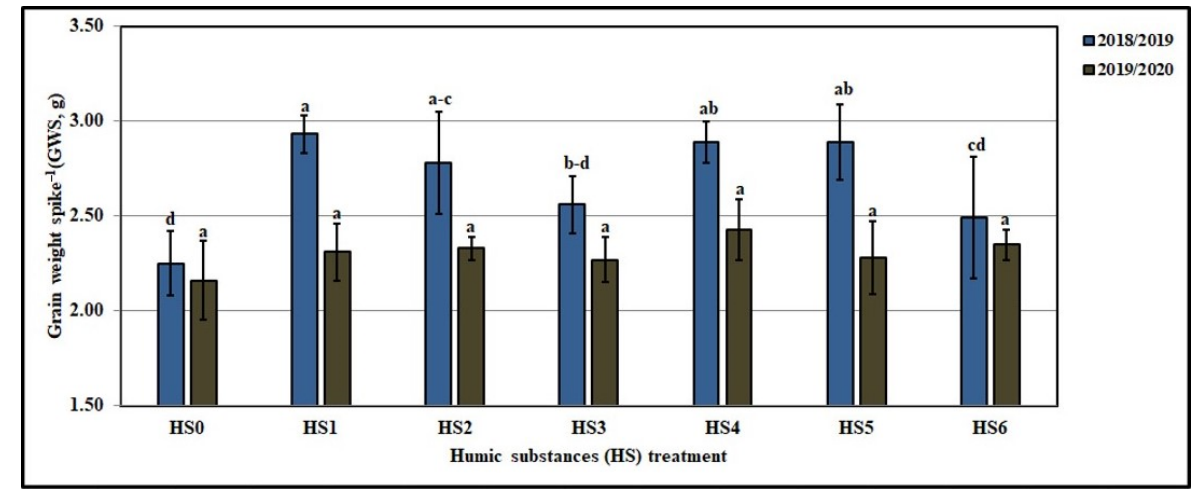
Figure 8. Influence of humic substances treatments on grain weight per spike (GWS, g) of some wheat varieties grown in clay loam soil in 2018/2019 and 2019/2020 seasons. Bars in the same years with a different letter indicate significant differences between treatments at p ≤ 0.01. HS 1, HS 2 , HS 3 represent HS applied as foliar spray at 1.0, 2.0, 4.0 g L − 1 , respectively, HS 4 , HS 5 , HS 6 represent HS applied as soil application at 5.04, 7.56, 10.08 kg ha − 1 .